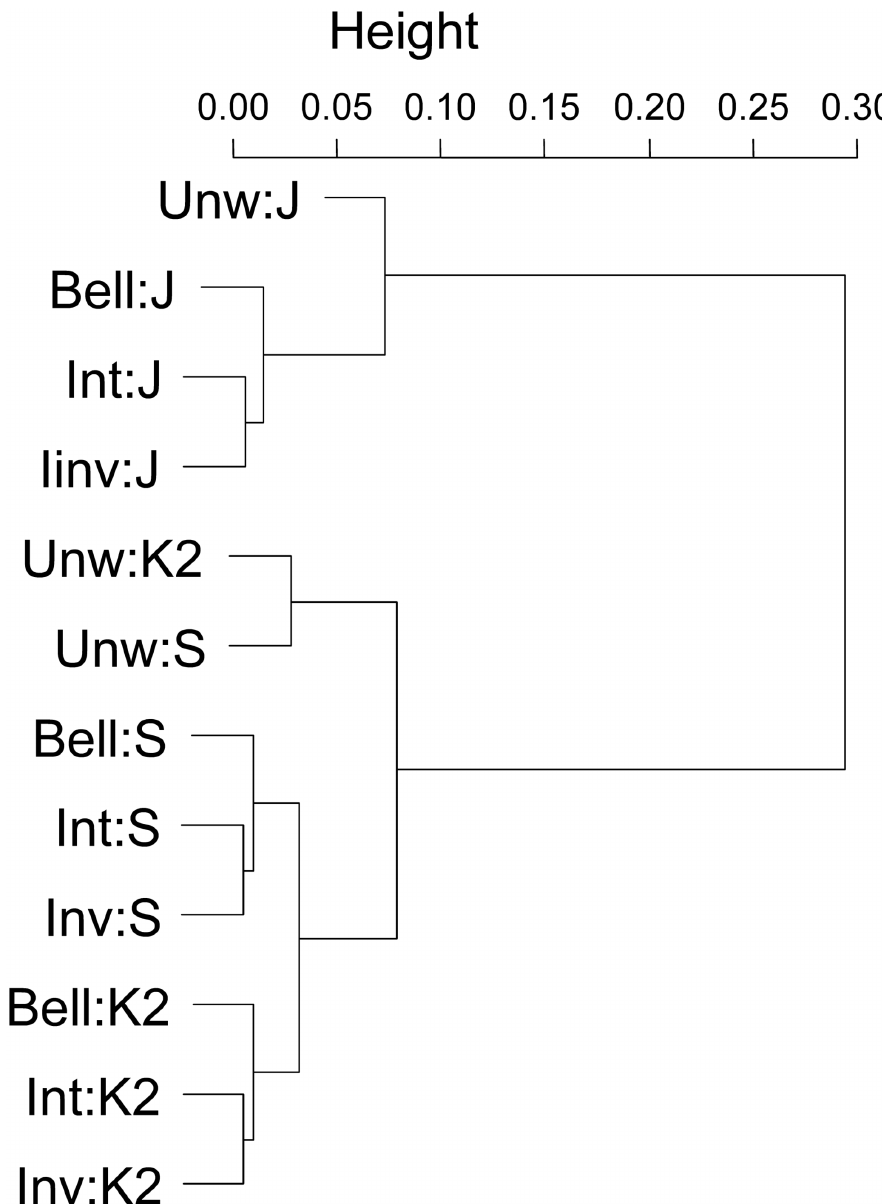
Fig 5. A dendrogram of the correlation between the 12 weighting-dissimilarity matrices. Mantel Tests were undertaken using Pearson correlation and 999 permutations. The actual correlation values are provided in S2 Table. All dissimilarity matrices were significantly correlated with p < 0.001. [Unw = unweighted, Bell = Bell weighting, Int = Integration weighting, Inv = Inverse weighting, K2 = Kulczinsky2; J = Jaccard; S =